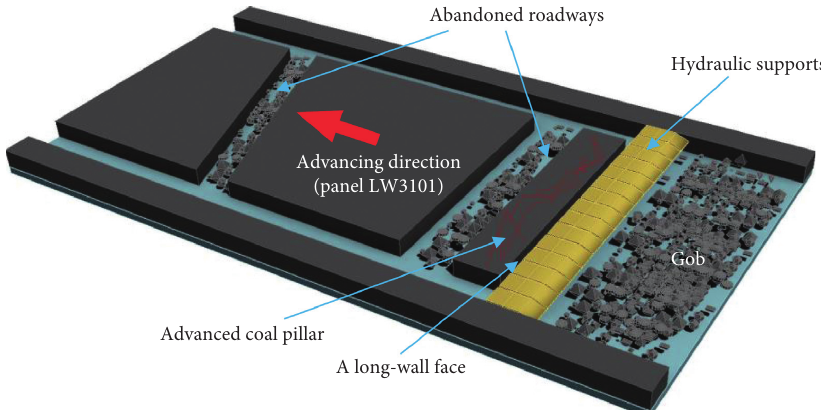
Figure 1: The spatial positional relation of panel LW3101 and abandoned roadways.